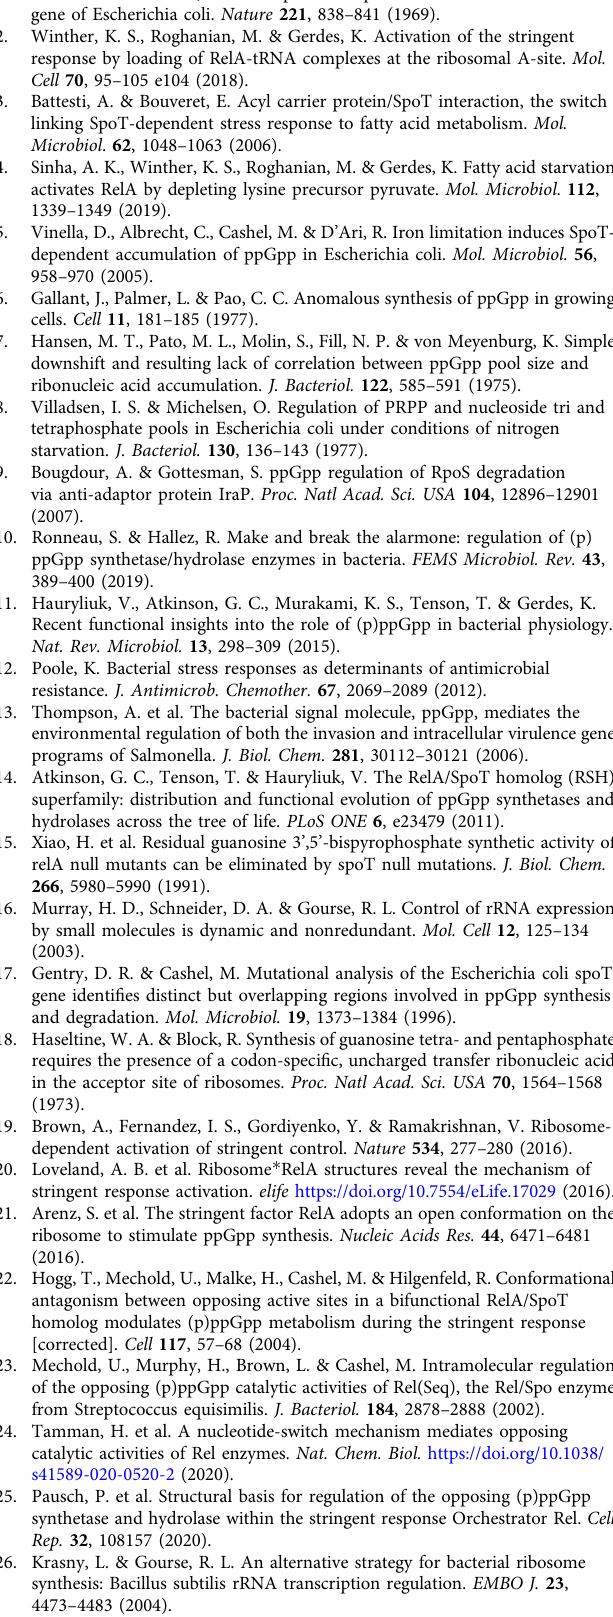
phosphorylated using T4 polynucleotide kinase (Thermo fi scher) and 0.5 μ Ci/ μ L [ γ P 32 ]-ATP for 40 min in Reaction buffer at 37°C. ATP was added to a fi nal buffer supplemented with 0.5% NP-40. Barcoded 5 ’ -linker (1.25 mM of L5Aa, L5Ab, L5Ad, L5Bb, L5Bc or L5Bd in Supplementary Table 1) was ligated to the sample RNA using T4 RNA ligase I in Reaction buffer containing 1U/ μ L RNAsin overnight at 16 °C. The resin washed three times in Wash buffer (50 mM